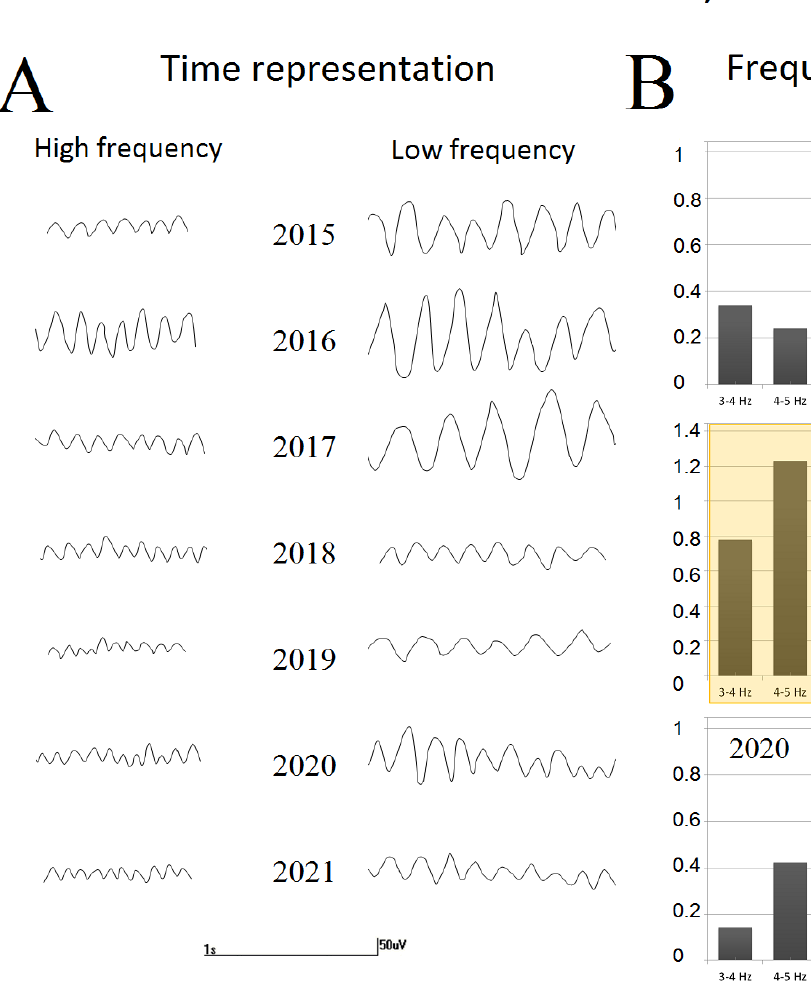
Figure 2. ( A ) The examples of fast and slow waves of sensorimotor ( µ ) rhythm (Cz). The EEG recordings marked by stars in Table 2 were used for the visualization. ( B ) The visualization of frequency rate of sensorimotor rhythm (SM_FrR) calculations for the EEG recording of patient U registered on 21 August 2015, 18 January 2017 and 20 March 2021; red vertical line corresponds to the median PSD that divides PSD into high and low values, marked respectively by blue and orange boxes. The averages over these boxes were used to calculate SM_FrR. x — frequency bands, y — PSD.